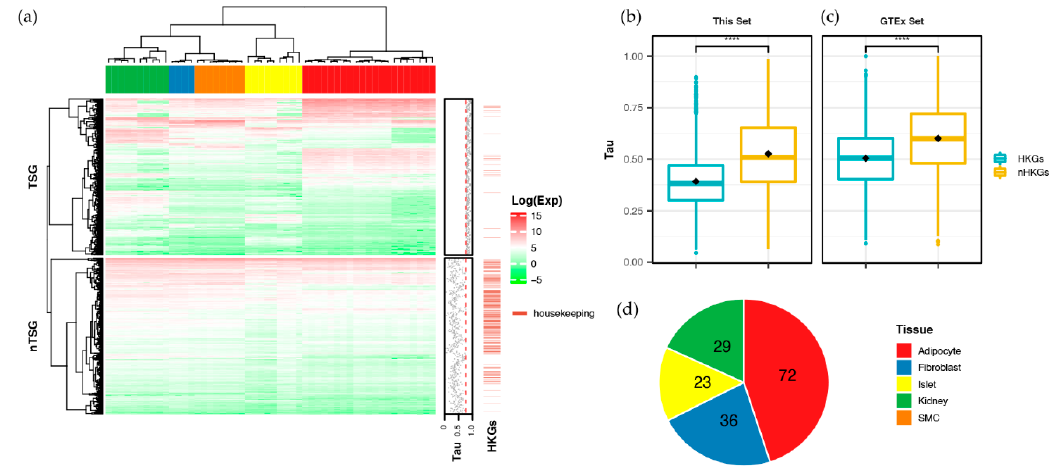
Figure 1. Gene expression revealed a tissue-specific pattern. ( a ) The gene expression pattern of protein-coding genes. ( b , c ) The distribution of Tau revealed whether the gene is housekeeping or not: our set ( b ) and the Genotype-Tissue Expression (GTEx) set ( c ). ( d ) A summary of all the common tissue-specific genes (TSGs) in the two data sets. nTSG, not TSG; HKGs, housekeeping genes; nHKGs, non-housekeeping genes.